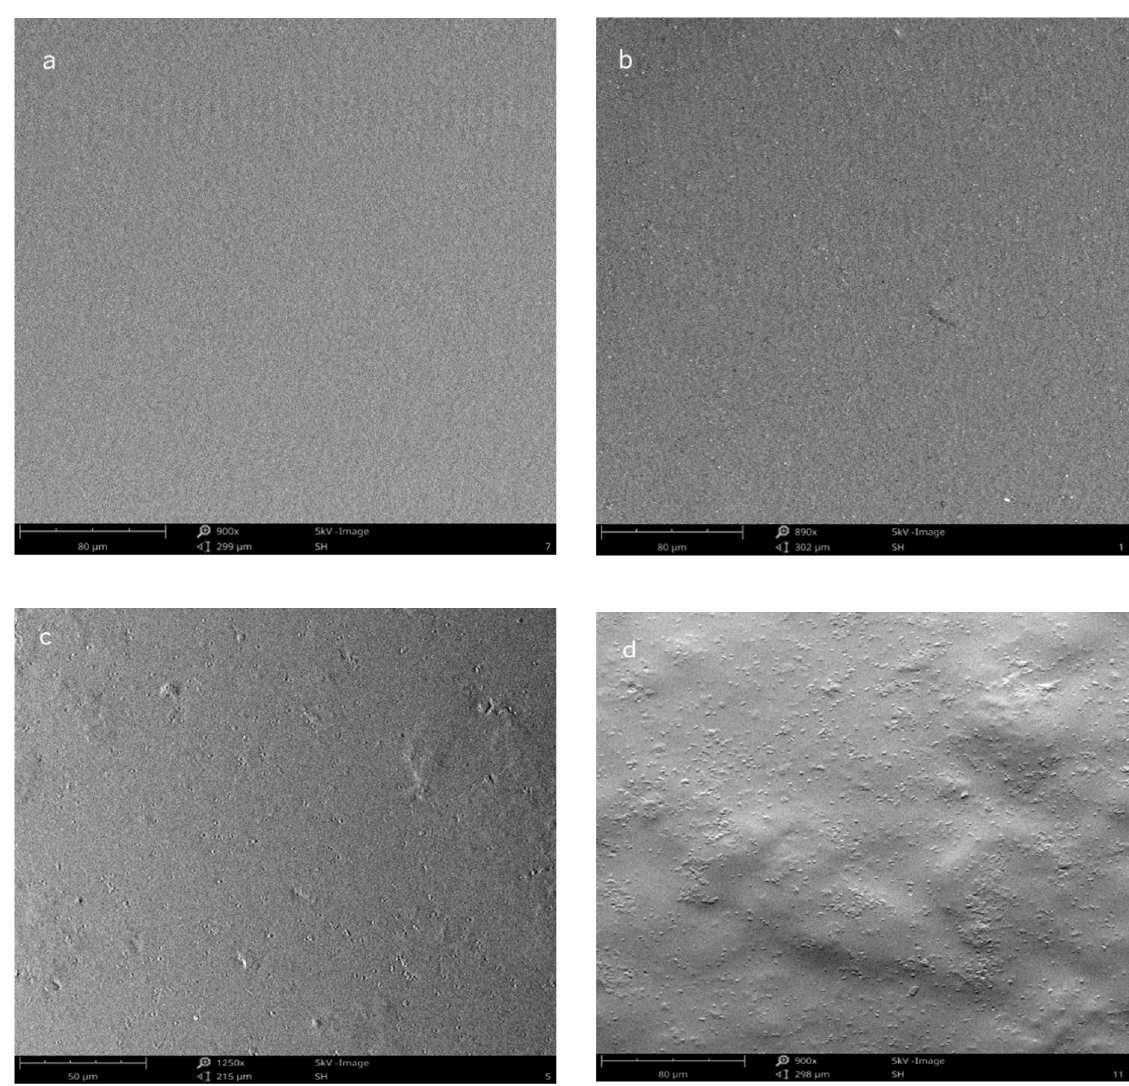
Figure 1. SEM photos of the surface of alginate films with ( a ) 0% (sample 7), ( b ) 0.30% (sample 1), ( c ) 1.00% (sample 5), and ( d ) 2.0% (sample 8) of amaranth phenolic compounds (film samples com- position is presented in Materials and Methods section).